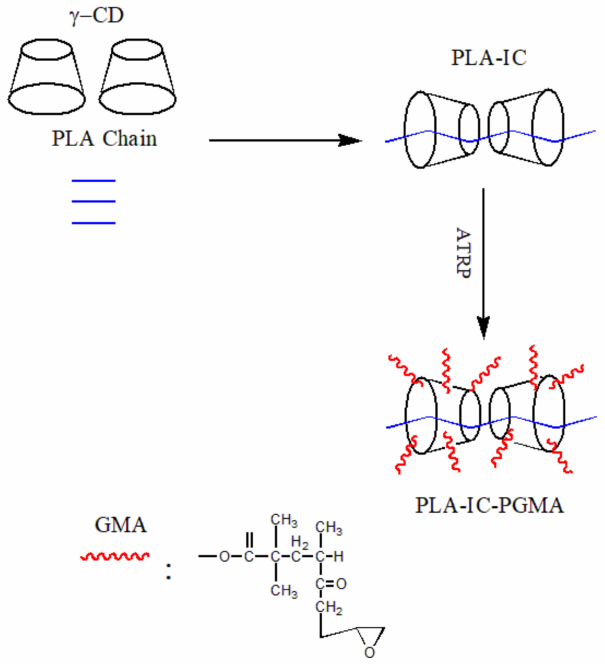
Figure 8. The synthetic route of polymers of